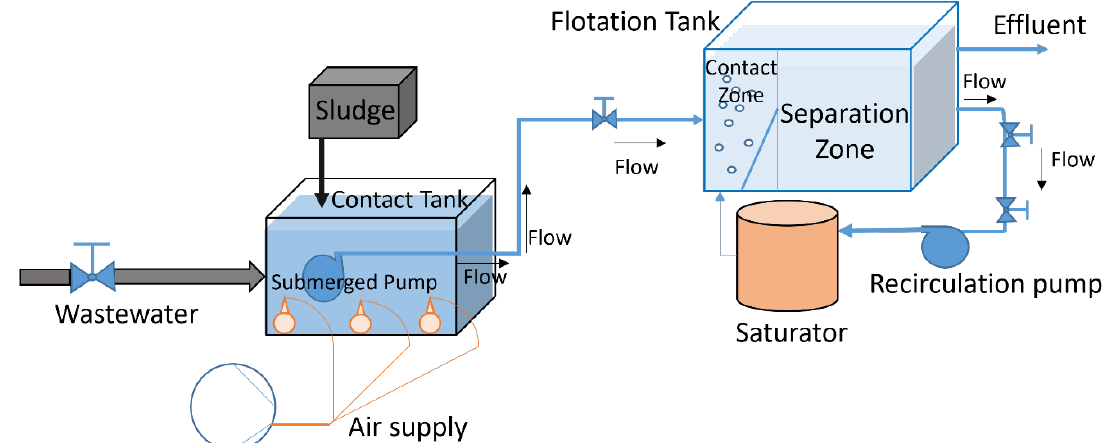
Figure 1. Schematic representation of experimental setup for the pilot-scale BEPT process.